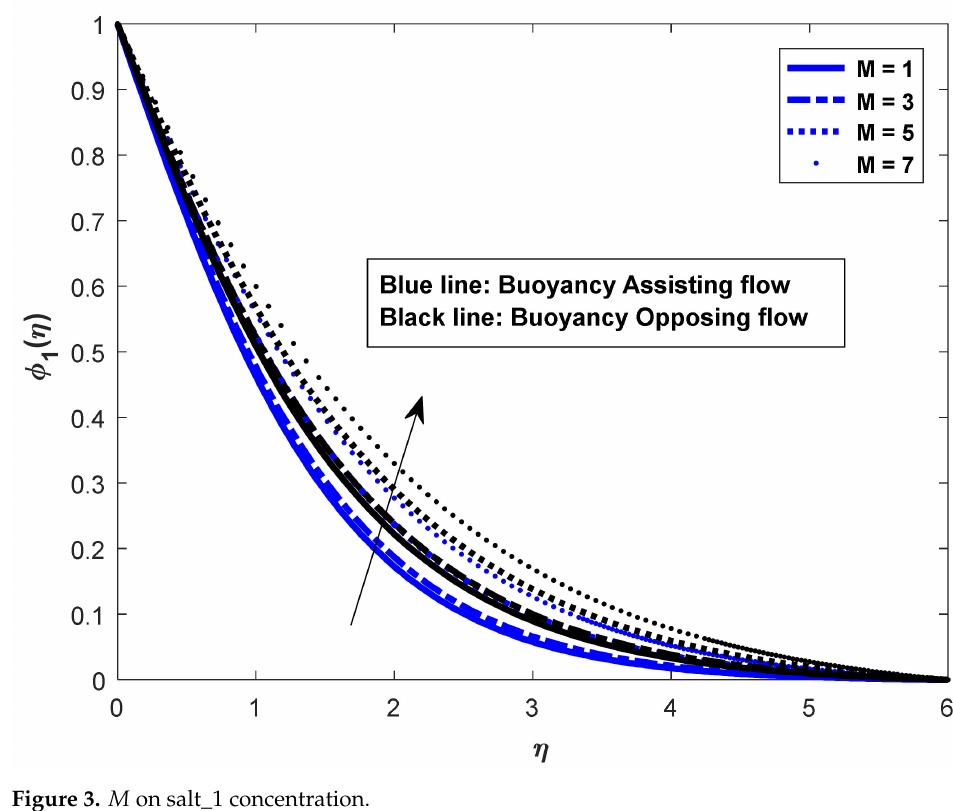
Figure 3. M on salt_1 concentration.